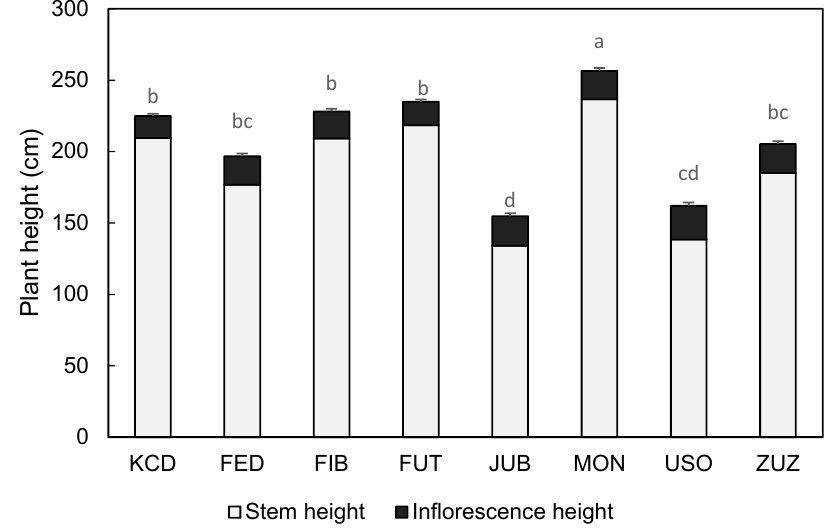
Figure 3. Maximum plant height of the cultivar studied (KCD = KC Dora; FED = Fedora 17; FIB = Fibrol; FUT = Futura 75; JUB = Jubileu; MON = Monoica; USO = Uso-31; ZUZ = Zuzana). Means followed by the same letter are not significantly different (SNK at the 5% level). Error bars are standard deviations.